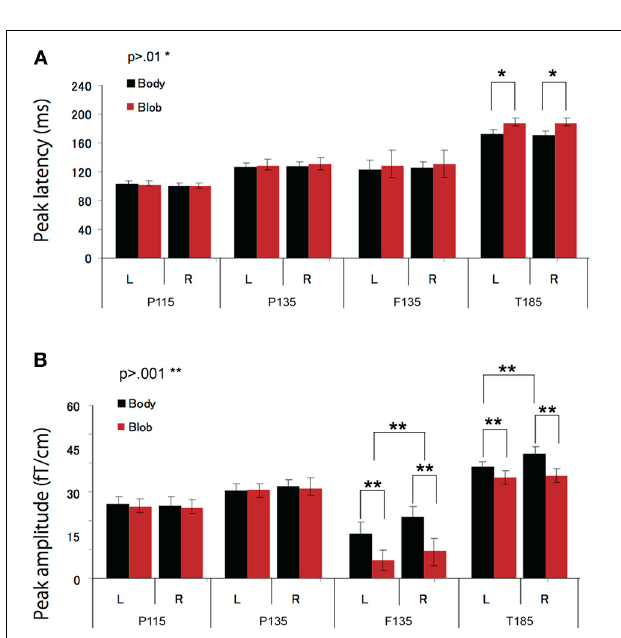
FIGURE 4 | Across-subjects mean ( ± SEM) of P115, P135,F135,and T185 peak latency (A) and amplitude (B) for “body” and “blob” responses.